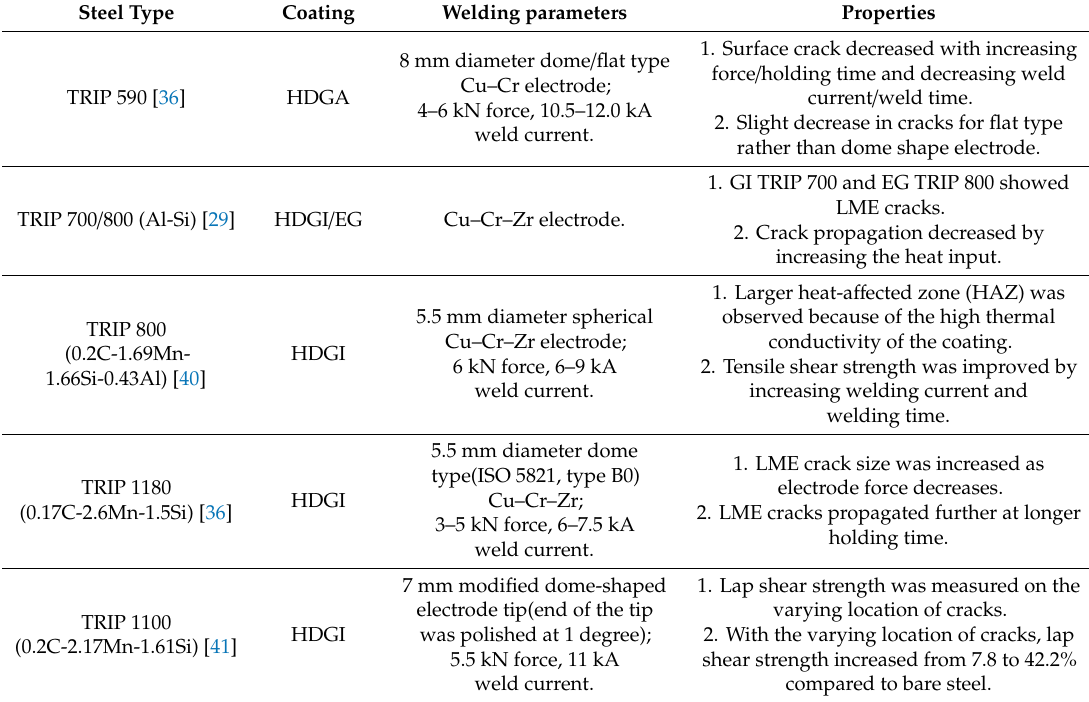
Table 1. Studies for LME of resistance spot-welded TRIP steel.